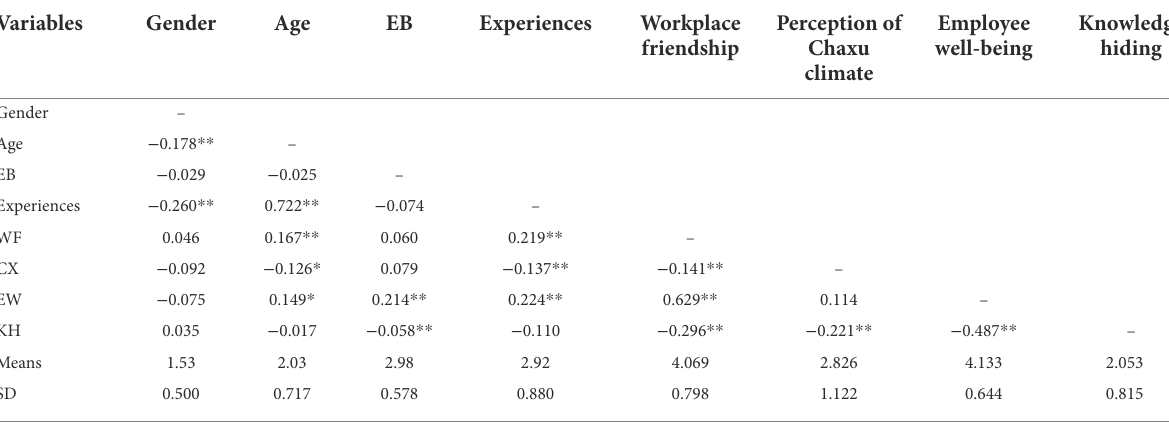
TABLE 2 Descriptive statistics and correlation analysis.